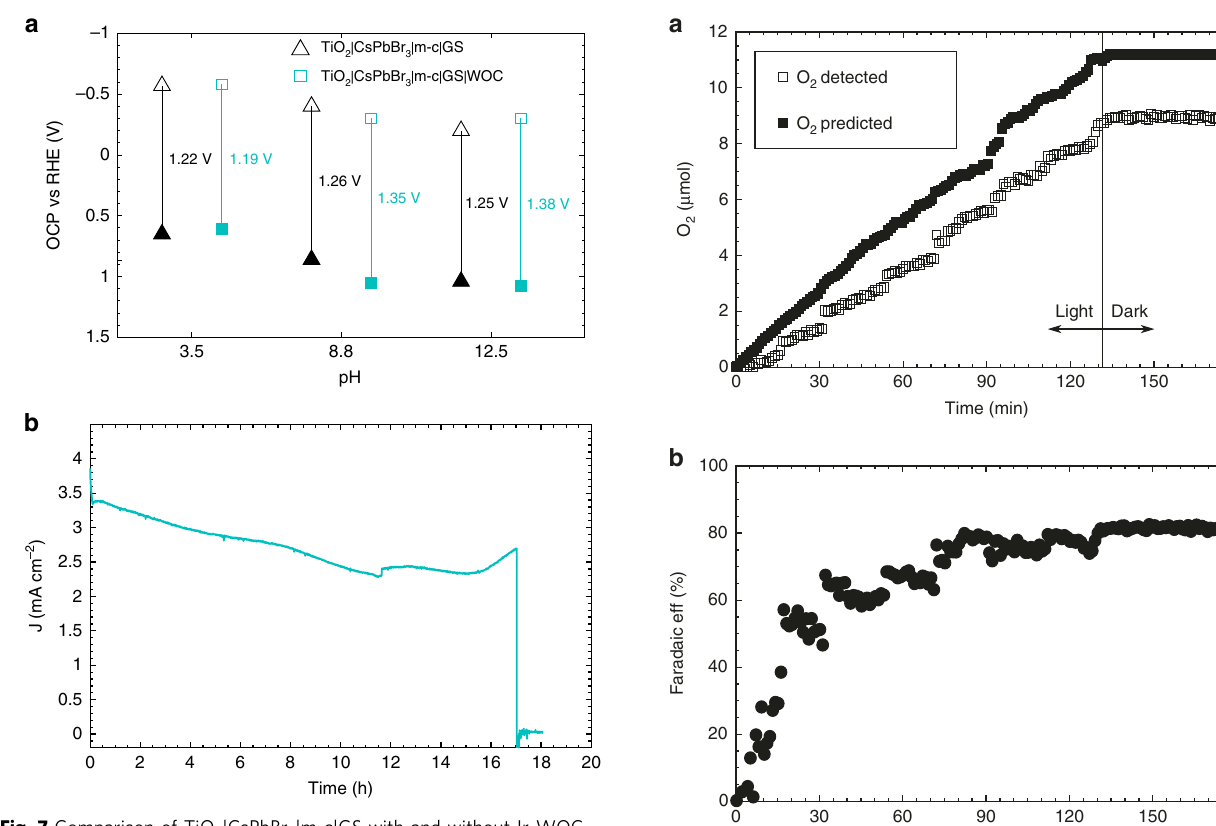
Fig. 7 Comparison of TiO 2 |CsPbBr 3 |m-c|GS with and without Ir-WOC. a Open-circuit potential (OCP) of photoanodes measured in 0.1 M KNO 3 solutions with different pH; Measurements performed in the dark are shown with solid symbols, while the ones performed under illumination are shown with open symbols; The photovoltage Δ V ph measured for each sample is given. b Chronoamperometric trace of TiO 2 |CsPbBr 3 |m-c|GS| WOC recorded at an applied potential of 1.23 V RHE . The electrolyte was 0.1 M KNO 3 adjusted to pH 2.5 with H 2 SO 4 , under continuous simulated solar light irradiation (AM 1.5 G, 100 mW cm − 2 )